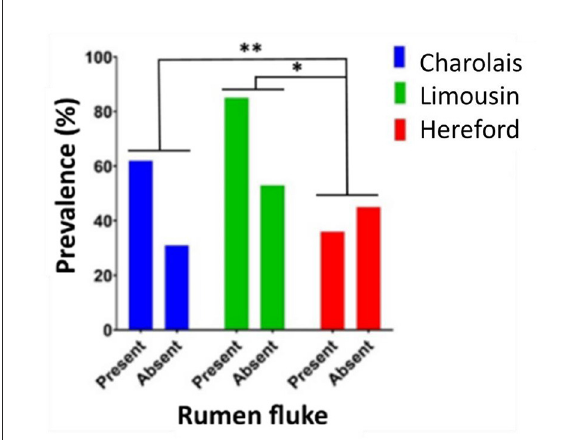
FIGURE4 The prevalence of rumen fluke infection in beef cattle carcases. The prevalence percentage of cattle carcases infected with (present) or not infected with (absent) rumen fluke sampled from Dungannon abattoir for the three most frequent beef breeds